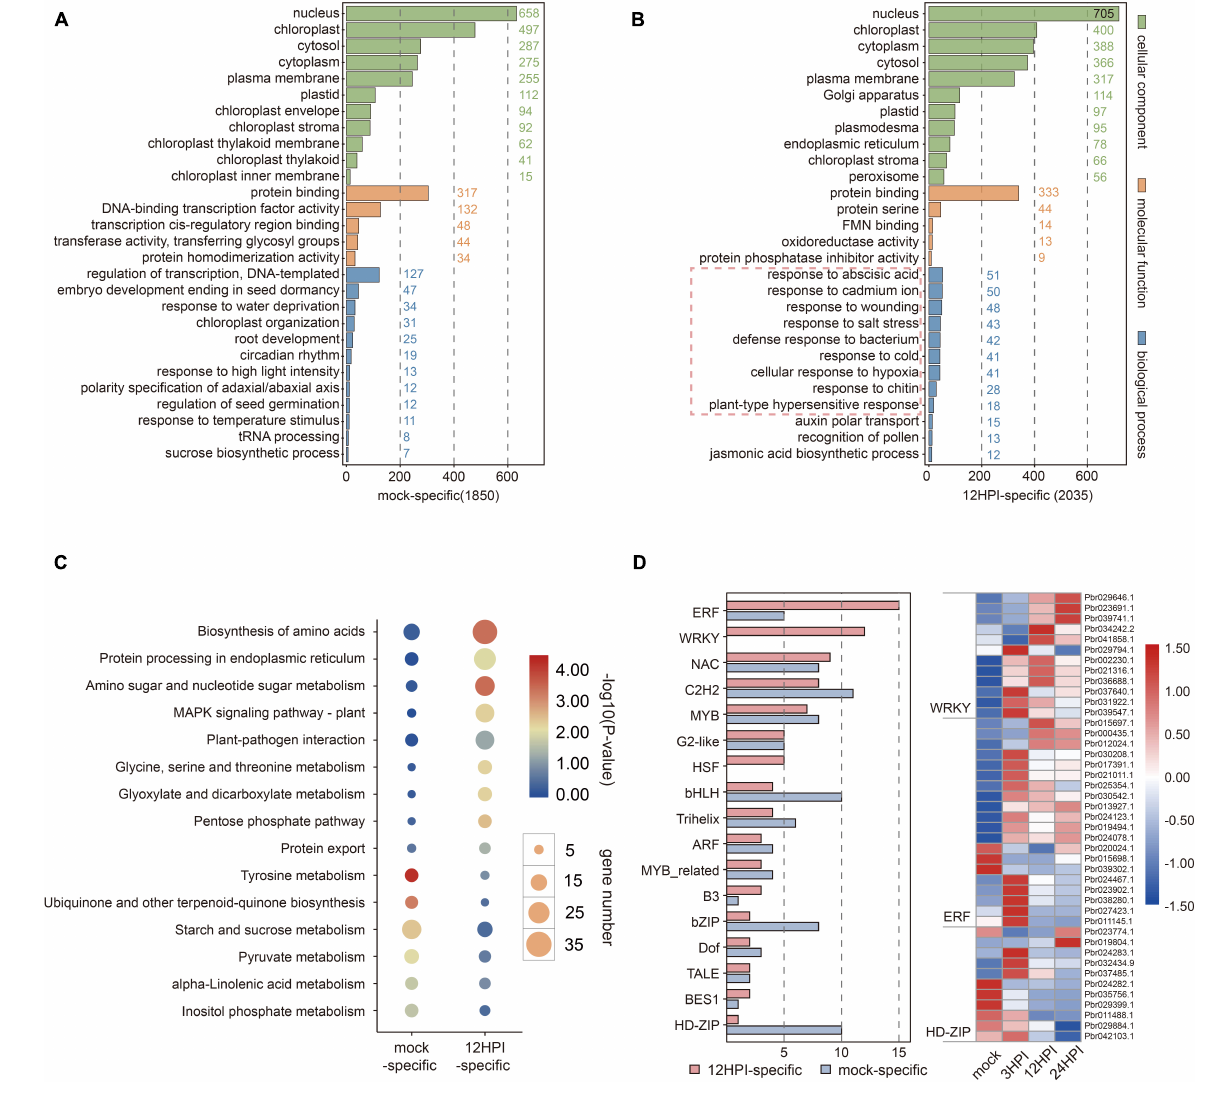
FIGURE 5 | Functional analysis of mock-specific and 12 HPI-specific m 6 A-modified genes. (A,B) Gene Ontology (GO) enrichment analysis of mock-specific and 12 HPI–specific m 6 A-modified genes. (C) KEGG pathway enrichment analysis of mock-specific and 12 HPI–specific m 6 A-modified genes. (D) Distribution and expression analysis of transcription factors (TFs) involved in mock and 12